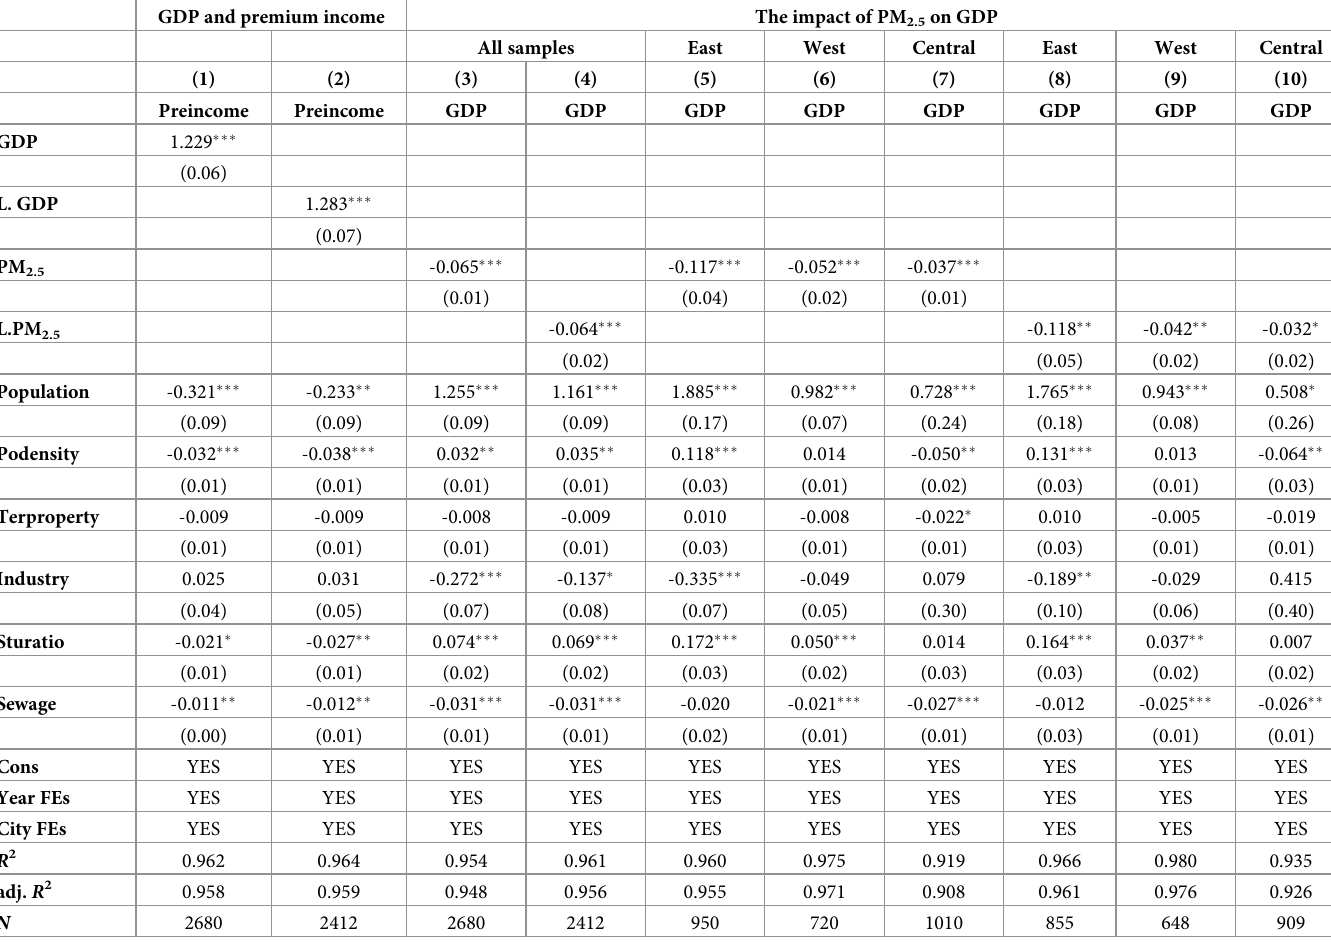
Table 5. Haze pollution and insurance development: The level of economic development. GDP and premium